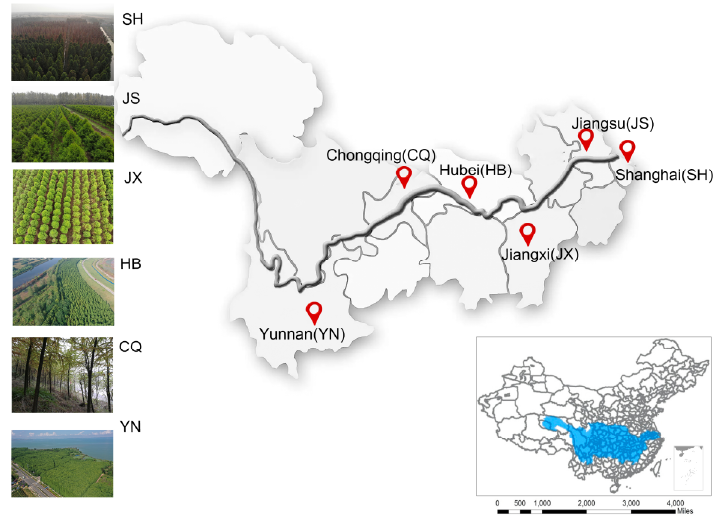
Figure 1. Spatial distribution of 6 T . Zhongshanshan stands in the Yangtze River Basin (blue area in the lower right corner).